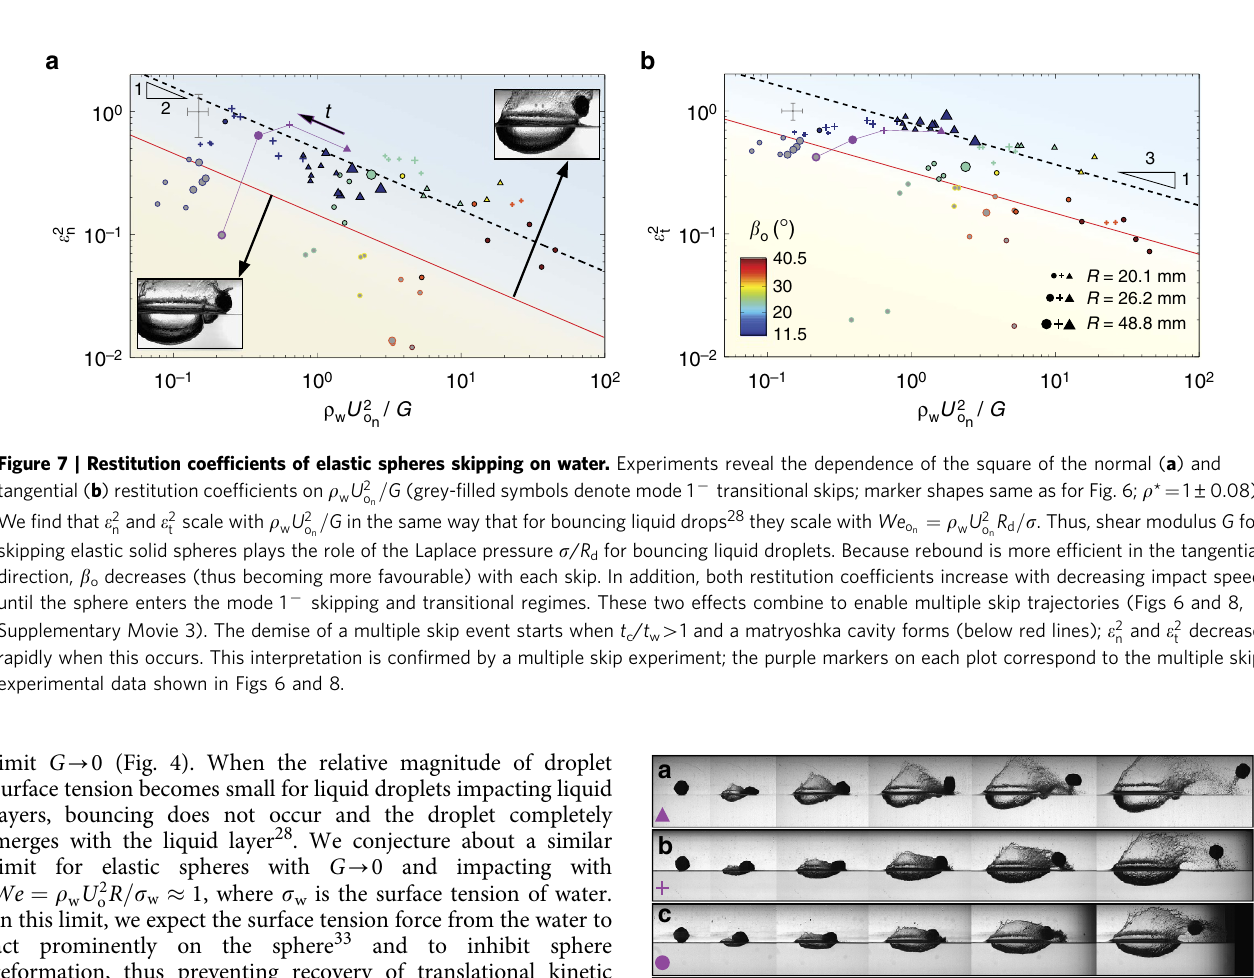
Figure 8 | An elastic sphere experiences several modes in a multiple skip event. These image sequences correspond to the four successive experimental impacts shown as purple symbols in Figs 6 and 7. ( a ) The first skip displays mode 1 þ behaviour. ( b ) The impact angle b o is reduced for the second skip, which is in the mode 2 regime. ( c ) The third impact (mode 1 (cid:2) skipping) occurs with approximately the same value of b o , but leads to and e 2 . ( d ) The last skip shows mode 1 (cid:2) transitional behaviour, reduced e 2 n t and results in such small values of the restitution coefficients that the ensuing impact ends in water entry (not shown). All times are normalized by the wave time computed from the mode 1 (cid:2) transitional skip ( d ).